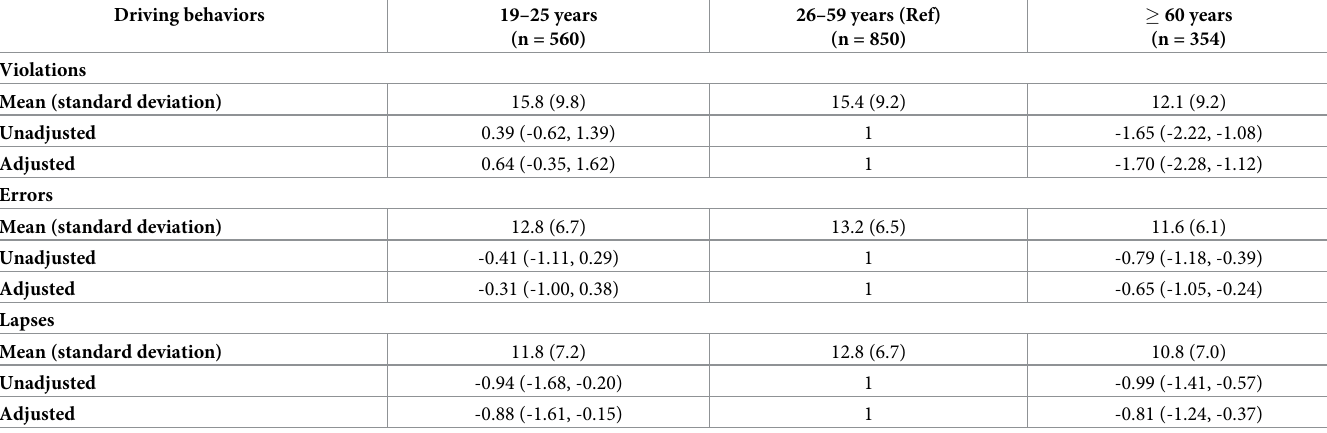
Table 2. Betas and 95% confidence intervals for non-professional drivers’ aberrant driving behaviors according to their age category. Driving